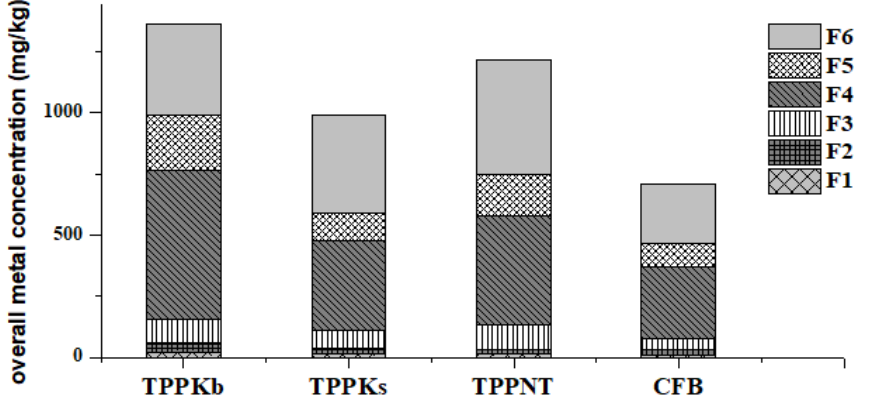
Figure 2. Overall trace element concentrations in F1-F6 fractions of fly ashes (TPPKb, TPPKs, TPPNT, and CFB).